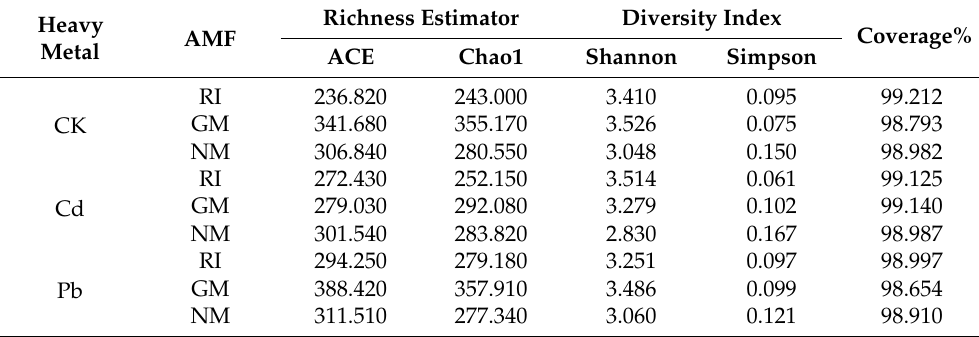
Table 5. Comparison between coverage and diversity estimators of litter bacterial communities under different